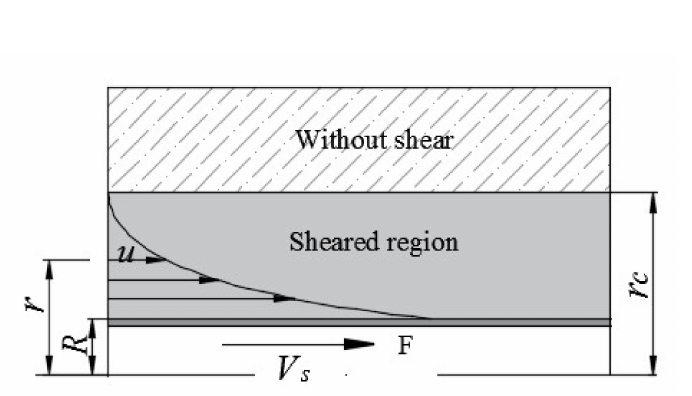
Figure 2. Shield shell-soil shear flow